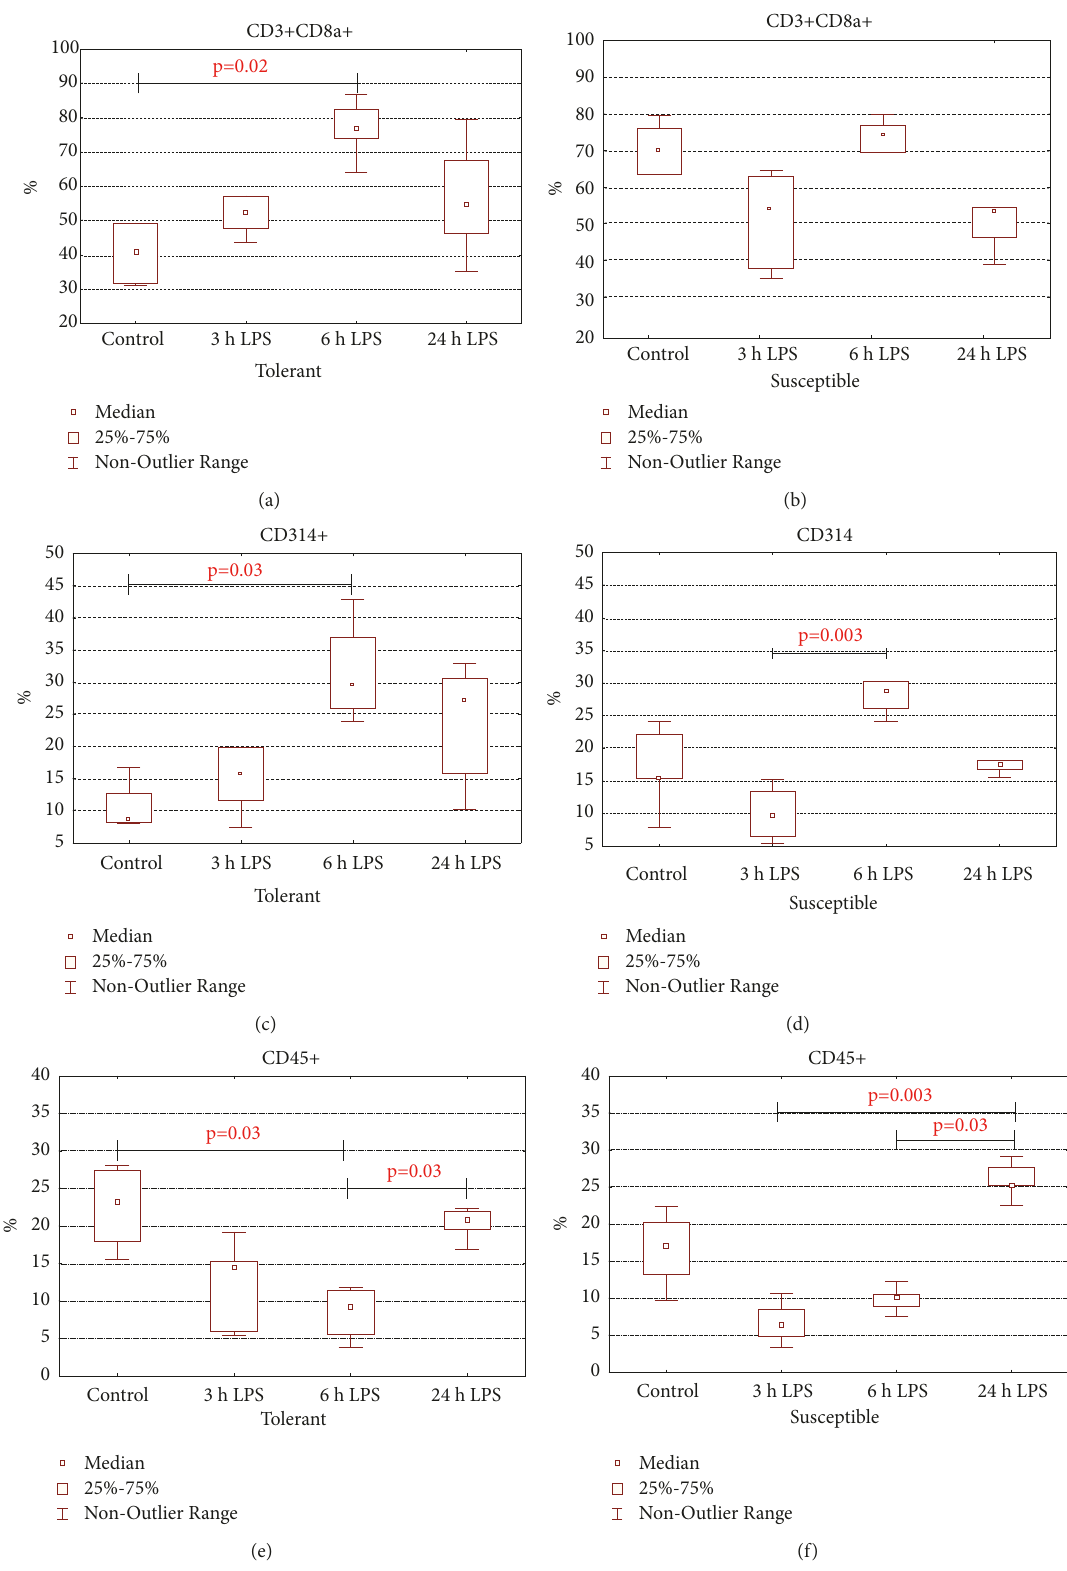
Figure 8: Therelativenumberof ((a),(b))cytotoxicT-lymphocytes(CD3+CD8a+),((c),(d)) NKcells(CD314+), and ((e),(f))B-lymphocytes (CD45+) in peripheral blood of tolerant- (a, c, and e) and susceptible- (b, d, and f) to-hypoxia rats after 3, 6, and 24 hours of LPS administration. Data are presented as median (25%, 75%); the statistical significance of differences ( p ) is determined by the Kruskal-Wallis method ( 𝑛 = 5 in each